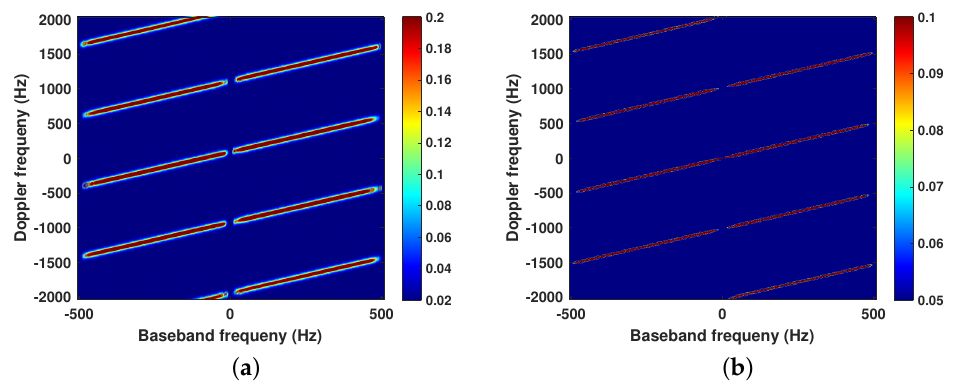
Figure 6. Doppler spectrum of five − channel SAR system versus channel phase error. ( a ) Without channel errors calibration. ( b ) Using the proposed calibration method.